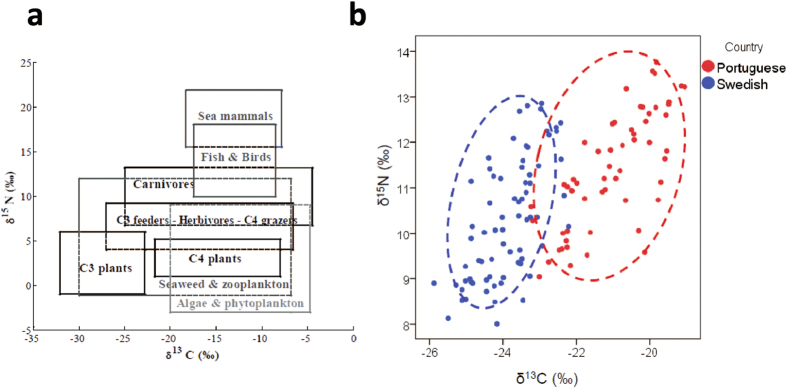
(a) Generalized isotopic trophic diagram for terrestrial and marine food webs34. (b) Stable isotope (δ13C and δ15Ν) diagram for Portuguese and Swedish plaques.